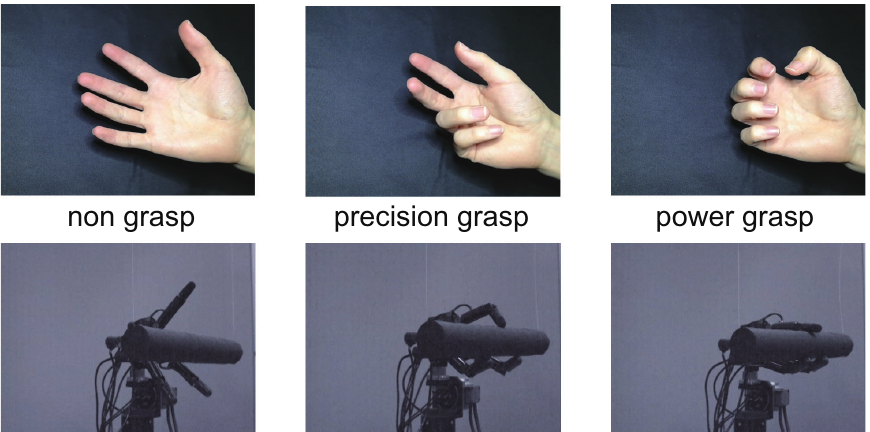
Figure 13. Experimental result of teleoperation; left, middle, and right show non-grasp, precision grasp, and power grasp, respectively.